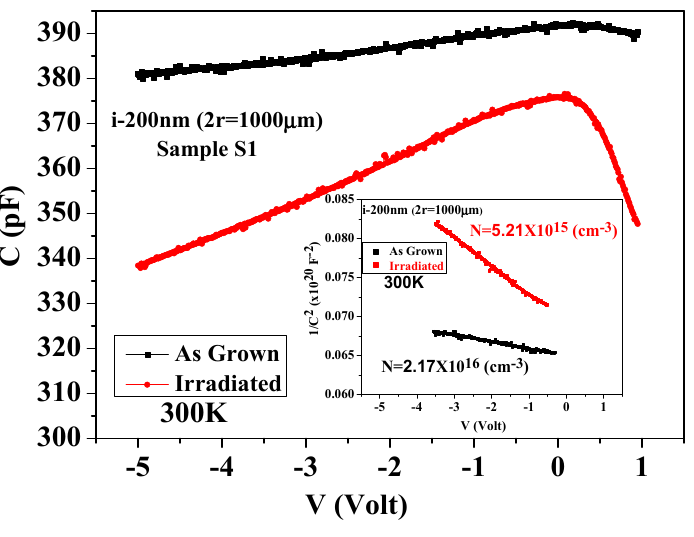
Figure 3. Typical capacitance-voltage (C-V) measurements performed at 1 MHz of sample S1. The inset shows the 1/ C 2 versus